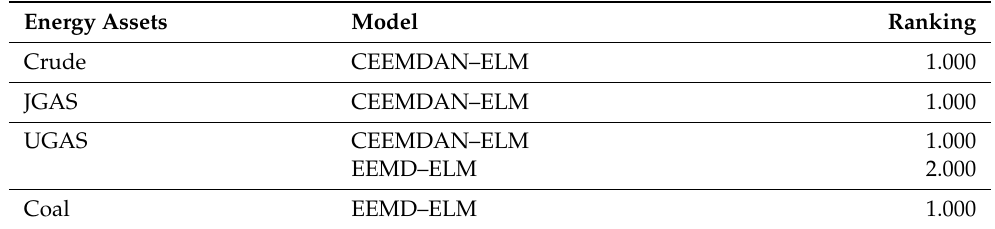
Table 6. Model confidence set: Resulting superiority set of models in 2019.